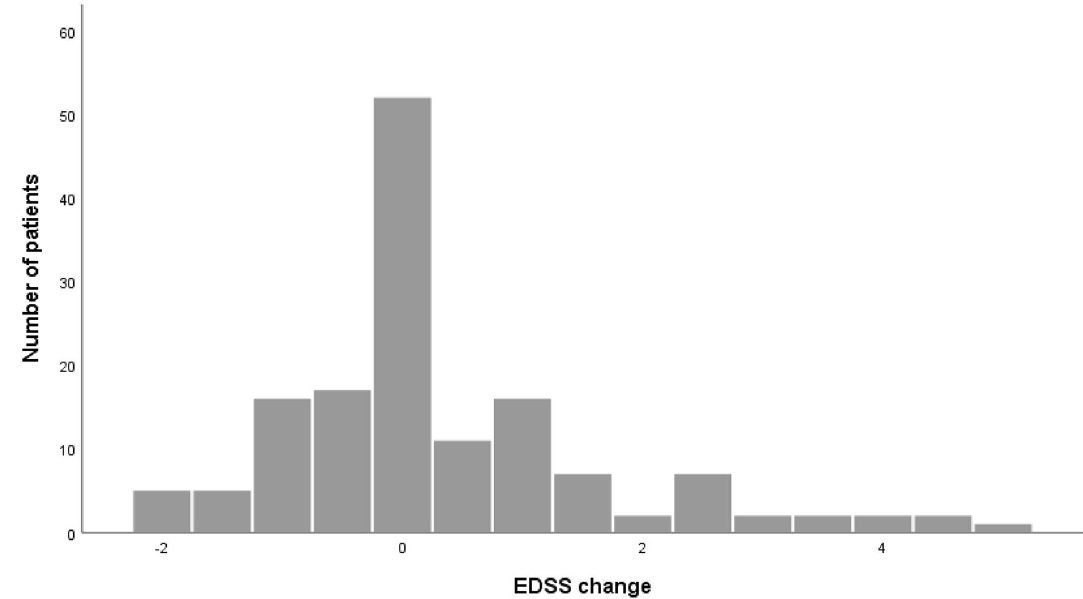
Figure 4. EDSS change on treatment with NTZ. Change of EDSS from time of NTZ treatment start to last visit on treatment for patients with treatment duration ≥ 2 years. Reason for discontinuation N (%) JCV positive 58